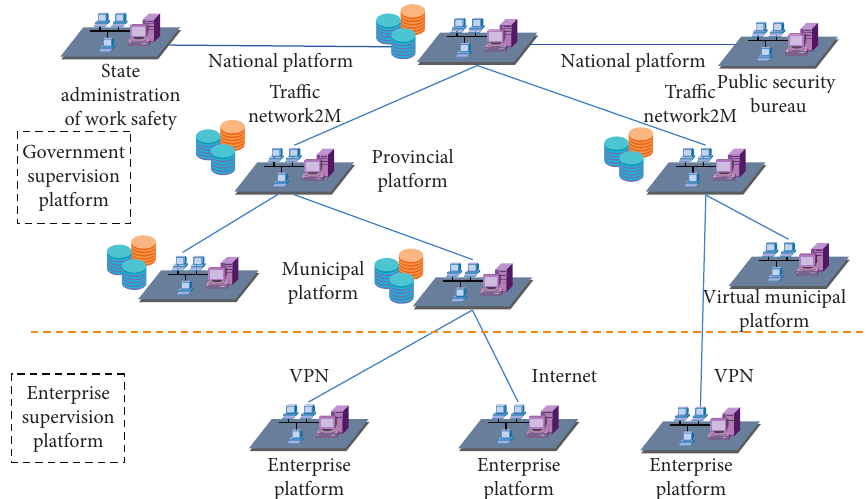
Figure 2: The organizational structure of the network joint control